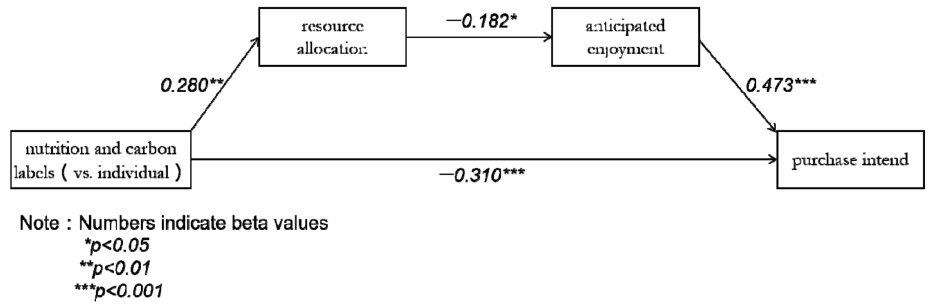
Figure 4. Study 1: The mediating effects of resource allocation and anticipated enjoyment in the relationship between positive labels and purchase